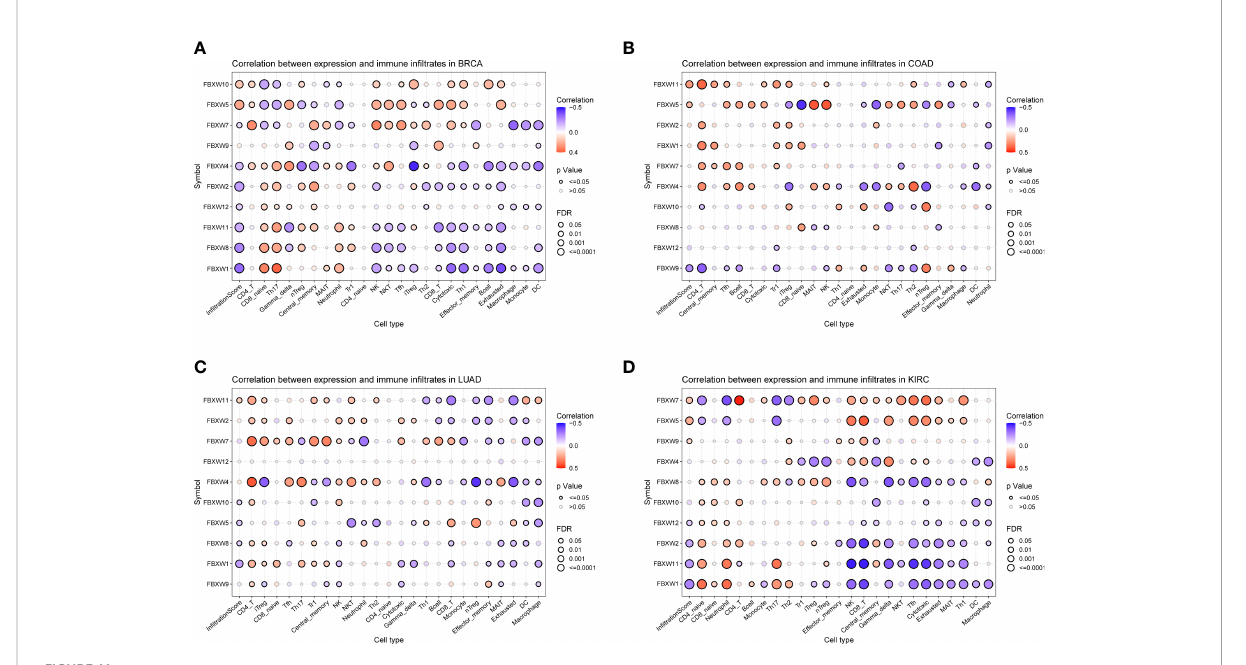
FIGURE 11 Association analysis of FBXW family gene expression with the immune-in fi ltration cells in four types of cancer. (A) in BRCA. (B) in COAD. (C) in LUAD. (D) in